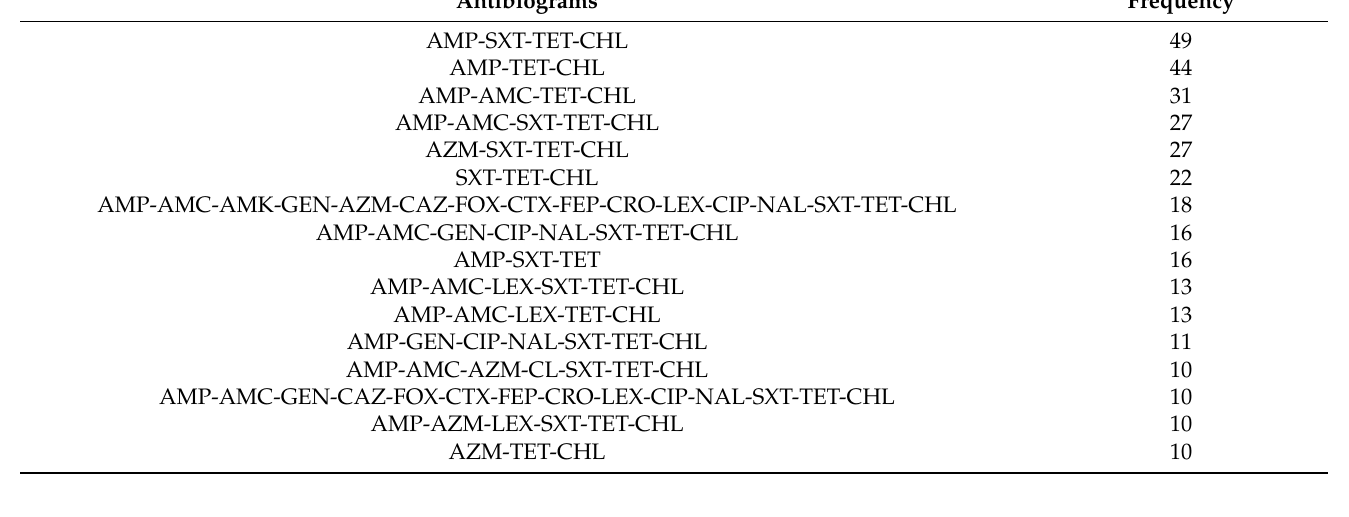
Table 1. Table depicting the most frequent multidrug-resistant (MDR) profiles of E. coli. Antibiograms Frequency